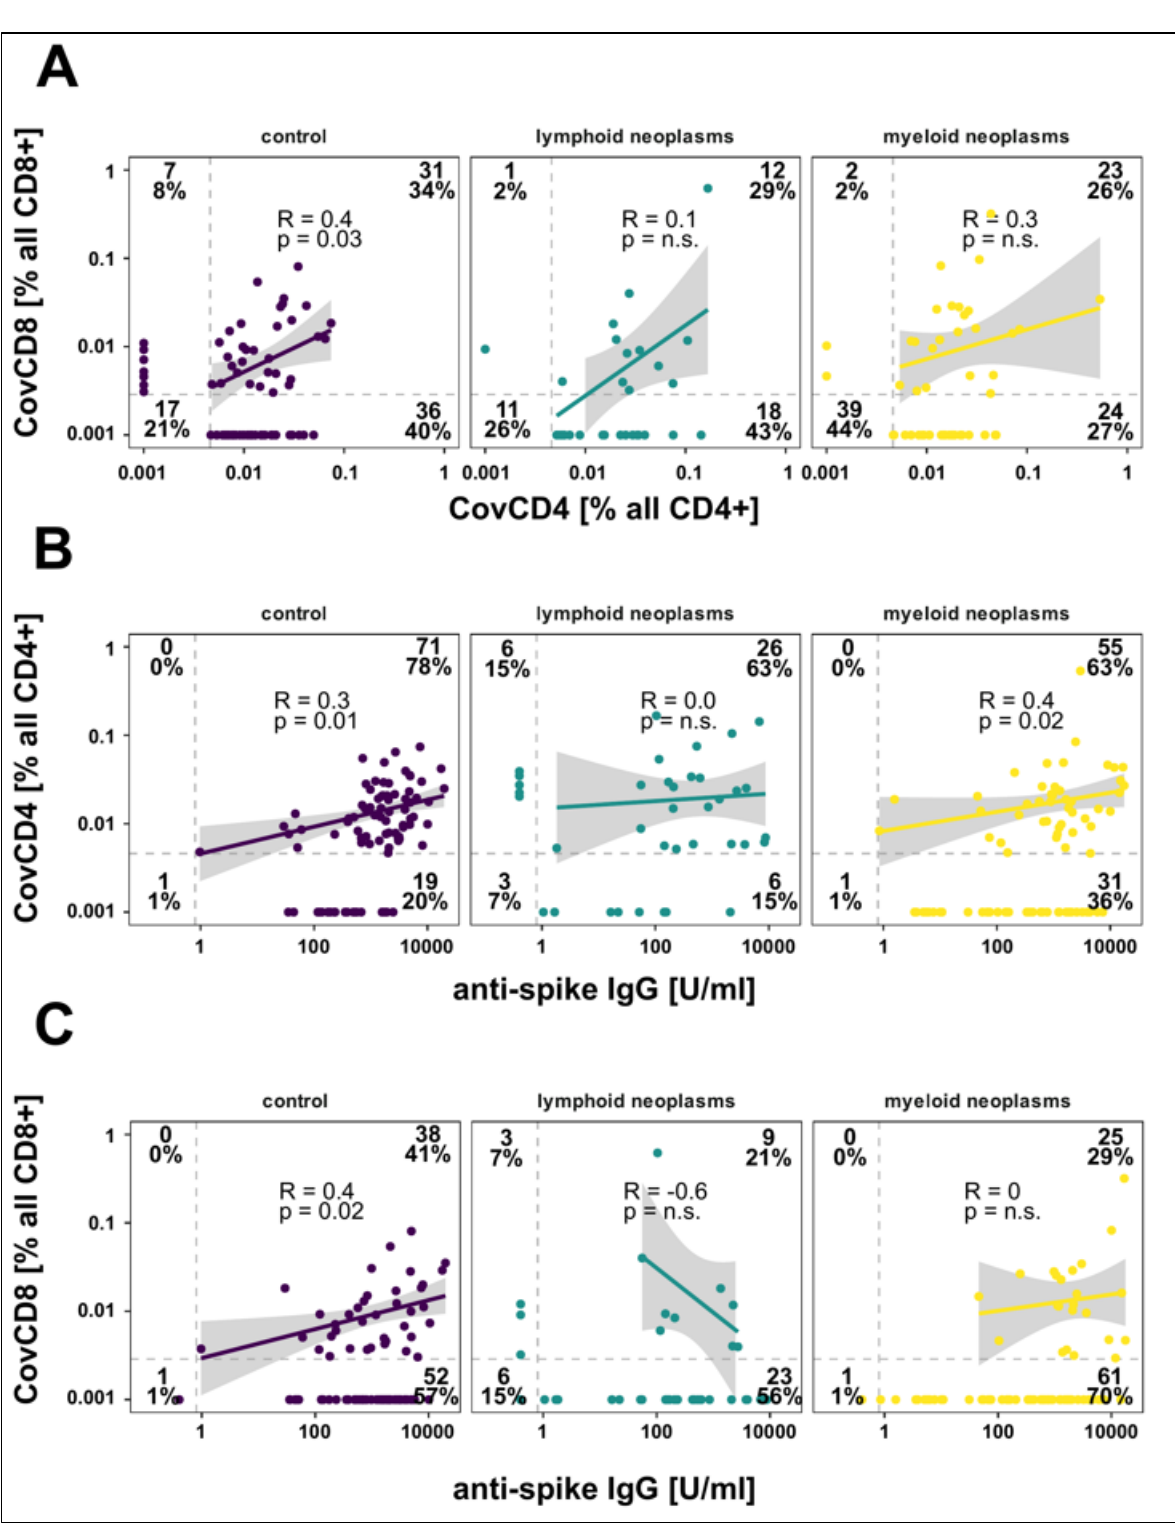
Figure 3 . Correlation between spike-specific CD4 + IL-2 + IFN γ + TNF α + (CovCD4) and CD8 + IL-2 + IFN γ + TNF α + (CovCD8) cell responses ( A ) and anti-spike IgG concentrations ( B , C ) on day 120 after vaccination . Results are shown for controls as well as for patients with lymphoid and myeloid neoplasms. Broken lines represent the limit of detection (LOD). Regression lines, Spearman correlation coefficients, and significance are calculated for double positive patients.